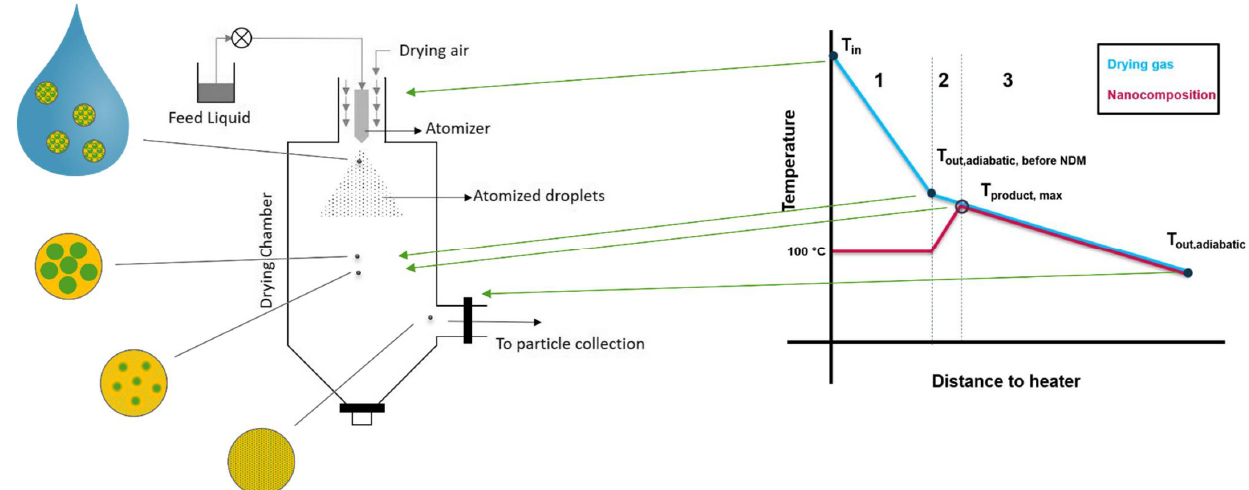
Figure 12. Nano-Dry-Melting (NDM) Scheme inside a spray dryer (adapted from [38], MDPI, 2019) connected to the simplistic temperature course during NDM. Blue: course of the drying gas temperature withing the spray dryer. Red: Course of the temperature of the nanocomposition. The courses are divided into three parts: 1: Evaporation of water. 2: Heating up of the Nanocomposition. 3: the Dry-Melting process. Depicted in yellow is the polymer matrix, the drug particles are in green. Since the feed rate during SD was very low (1.5 g/min), it can be assumed that any heat loss due to the NDM and evaporation process was relatively small. The huge differ- ence between the calculated T out,adiabatic,before DisP of 184 °C and the real T out of 85 °C therefore